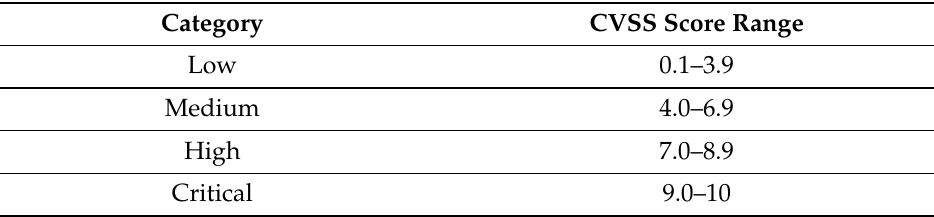
Figure 4. Different metric groups of CVSS Version 2. Table 2. Qualitative risk severity rating scale for different categories based on